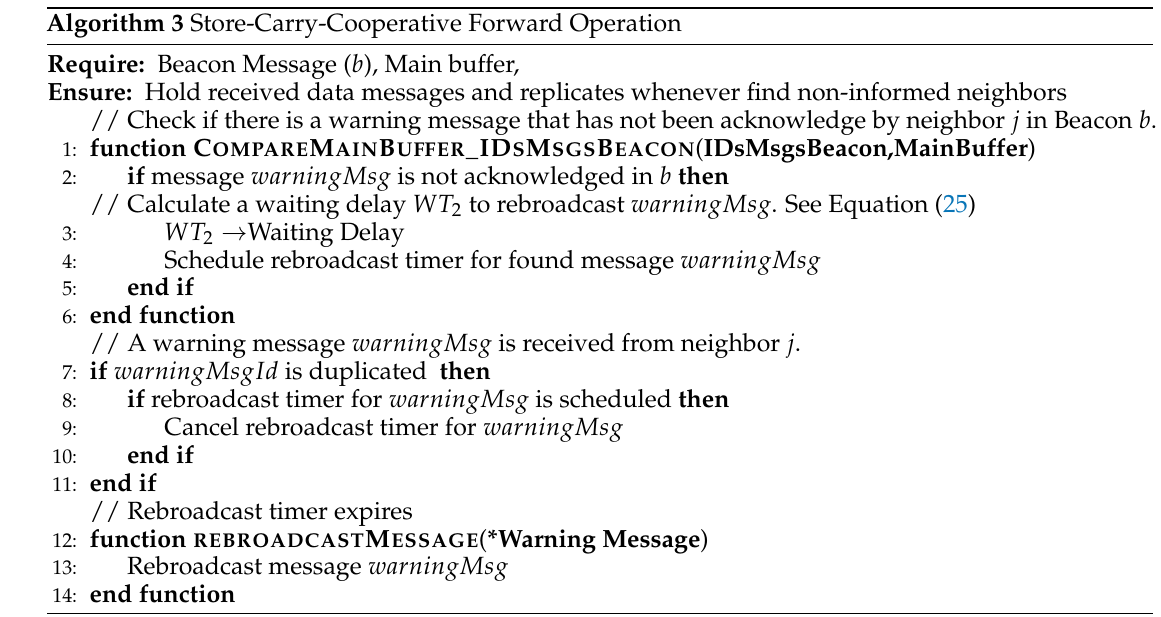
Algorithm 3 Store-Carry-Cooperative Forward